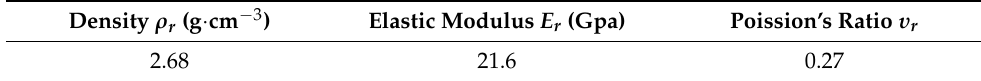
Table 7. Rock block parameter.